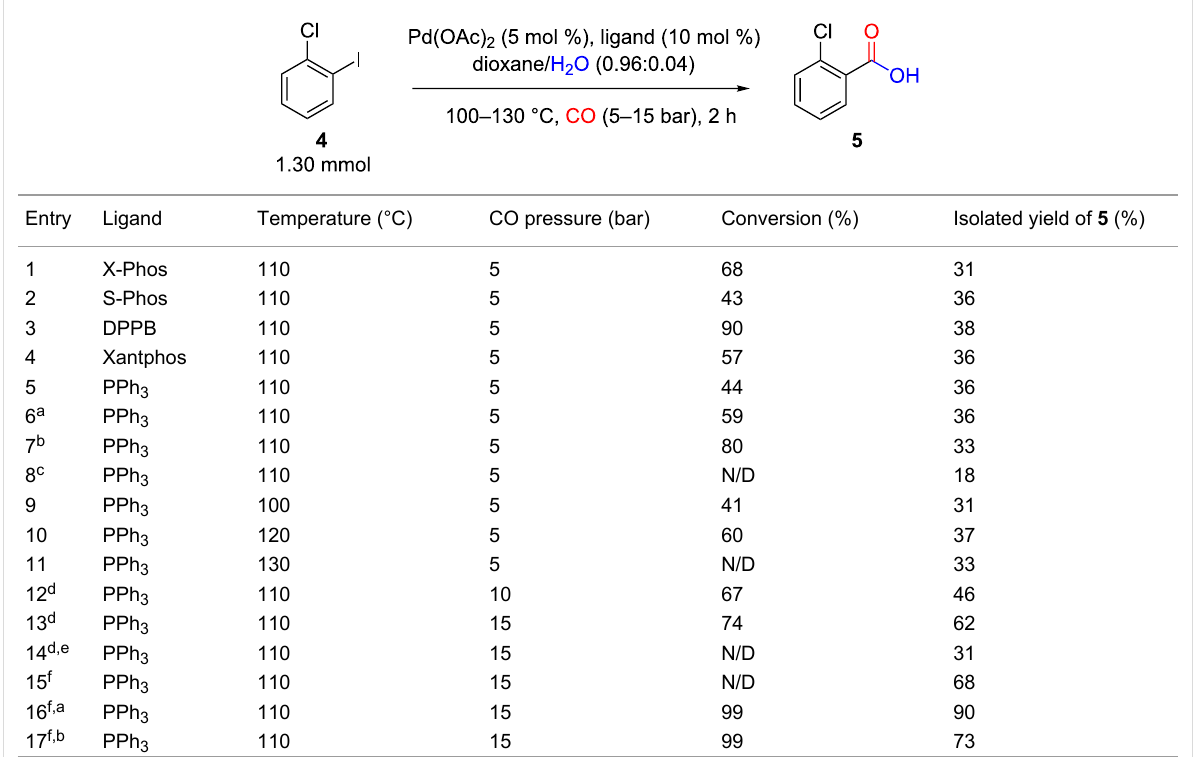
phosphine catalyst system under refluxing conditions with